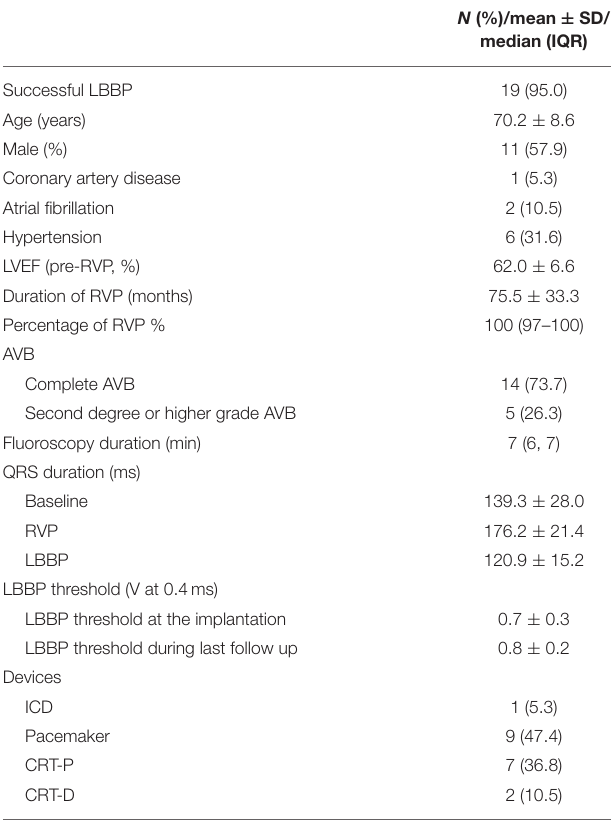
TABLE 1 | Baseline clinical characteristics of